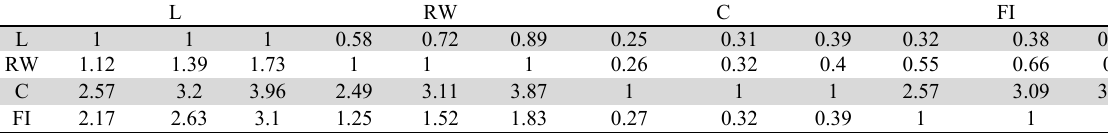
Aggregated fuzzy comparison matrix of criteria (Process) L